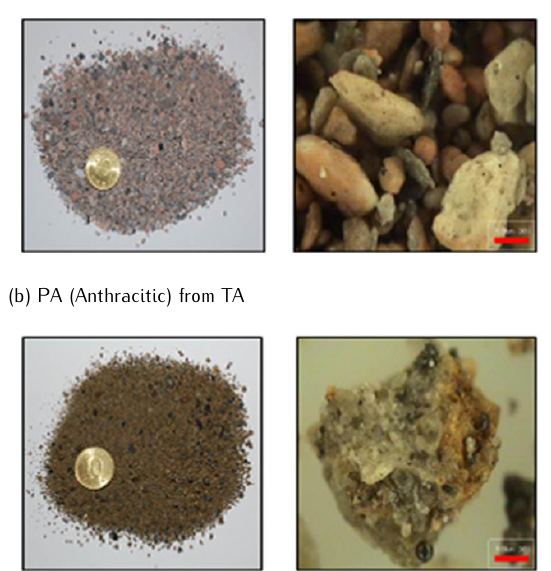
Table 3. Properties of HWRA.